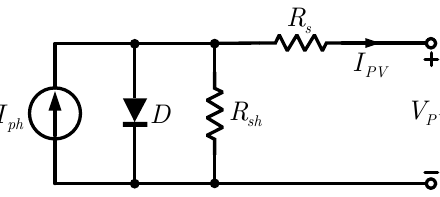
Figure 1. Single-diode model of a PV cell.